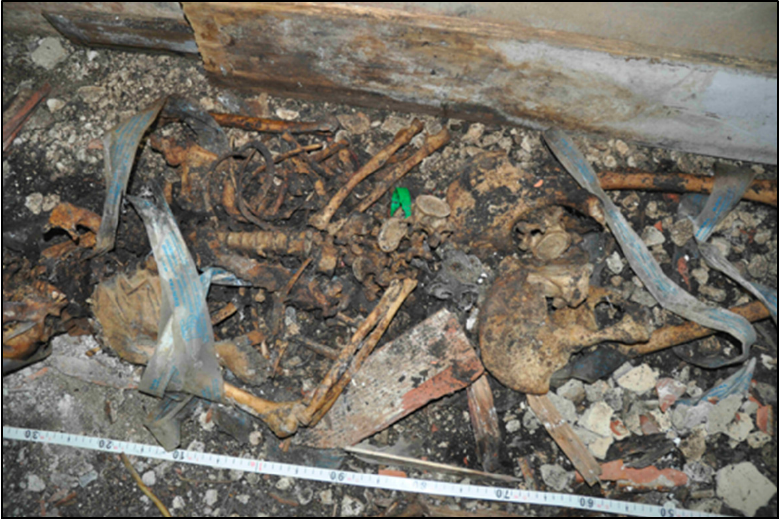
Figure 2. Arrangement of the remains at the time of discovery. The right shoulder bones (clavicle, humerus, and scapula) were wrapped in a cotton fabric.